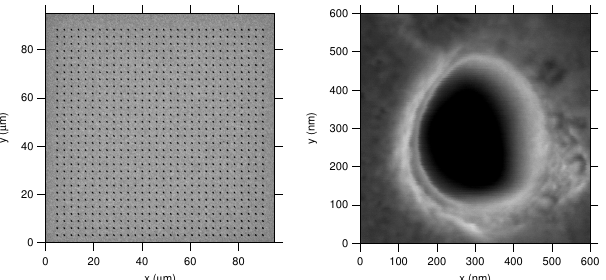
Figure 1. Scanning electron micrographs of ion-milled zero-mode waveguides. The ZMW consists of 200 nm holes in a 100 nm gold film. The ZMW array is 33 ×